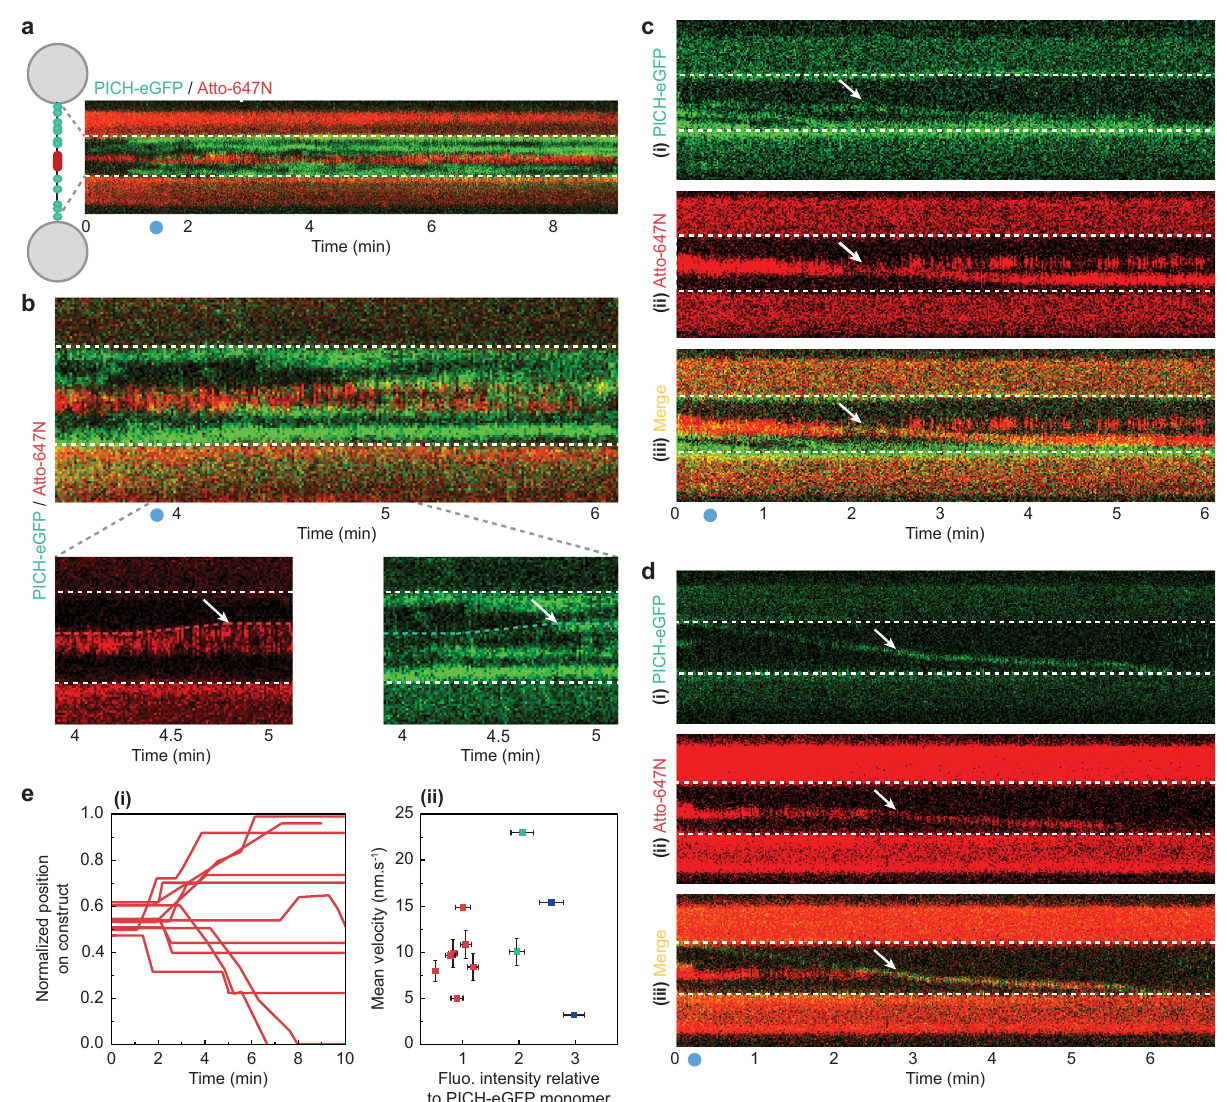
Fig. 4 | PICH can slide histones along the DNA. a Schematic representation ( left ) and representative kymograph ( right ) of a nucleosome-array construct with Atto- 647N-labelled histones (red), at 10pN in a micro fl uidic channel containing PICH- eGFP (green) and ATP. The region of the kymograph depicting the nucleosome- array construct is indicated by the dashed white lines ( b ), Top : Representative kymograph of a nucleosome-array construct with Atto-647N-labelled histones (red), at 10pN in a micro fl uidic channel containing PICH-eGFP (green) and ATP. Bottom : A zoom-in of the Atto-647N signal ( left ) and PICH-eGFP signal ( right ) highlights histone displacement. Histone displacement (red dashed line) co- localizes with PICH-eGFP translocation (green dashed line). White arrows indicate collision of the co-translocating PICH and histones with additional PICH protein. c Representative kymographs at 12.5pN, showing PICH-eGFP (green) ( i ), Atto647N labelled histones (red)( ii ), and a composite of the two ( iii ).Inthese kymographs, a PICH-eGFP monomer co-localizes with Atto-647N signal at the start of the